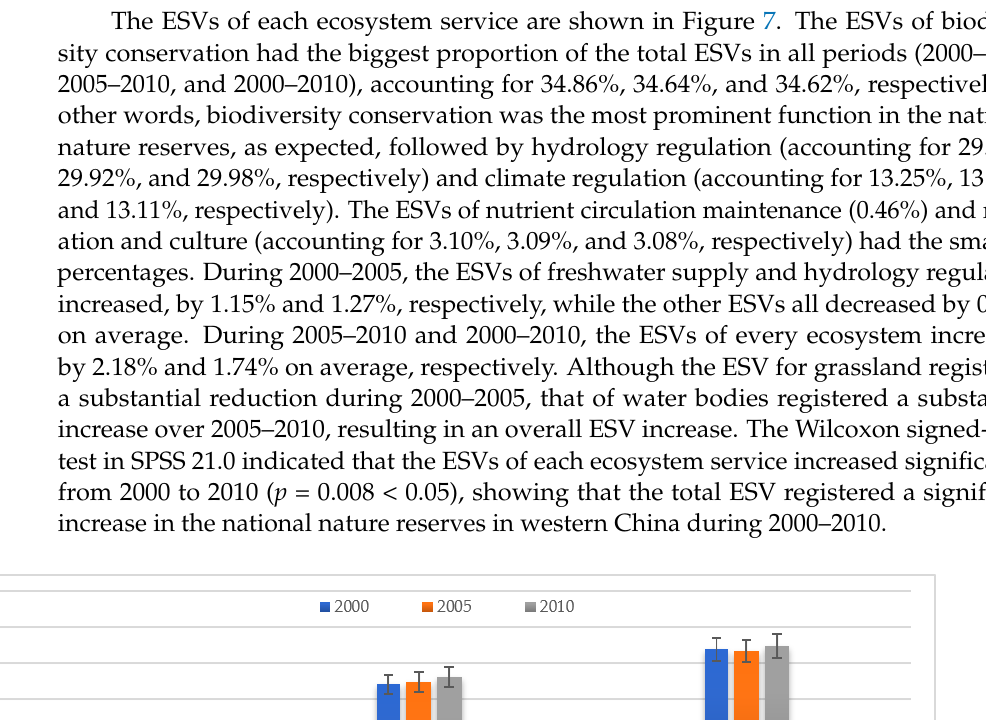
Figure 6. Contribution rates of land-use types.